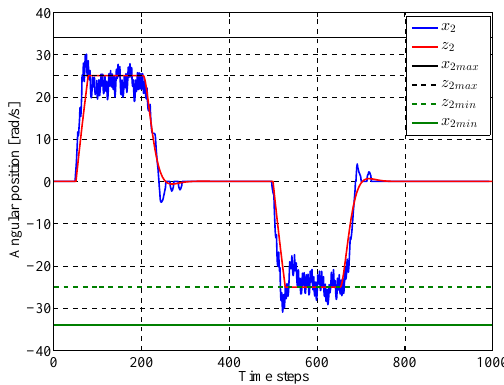
Figure 11: The angular velocity z 2 of the nominal model for the nominal MPC, and x 2 of the real plant for the proposed control